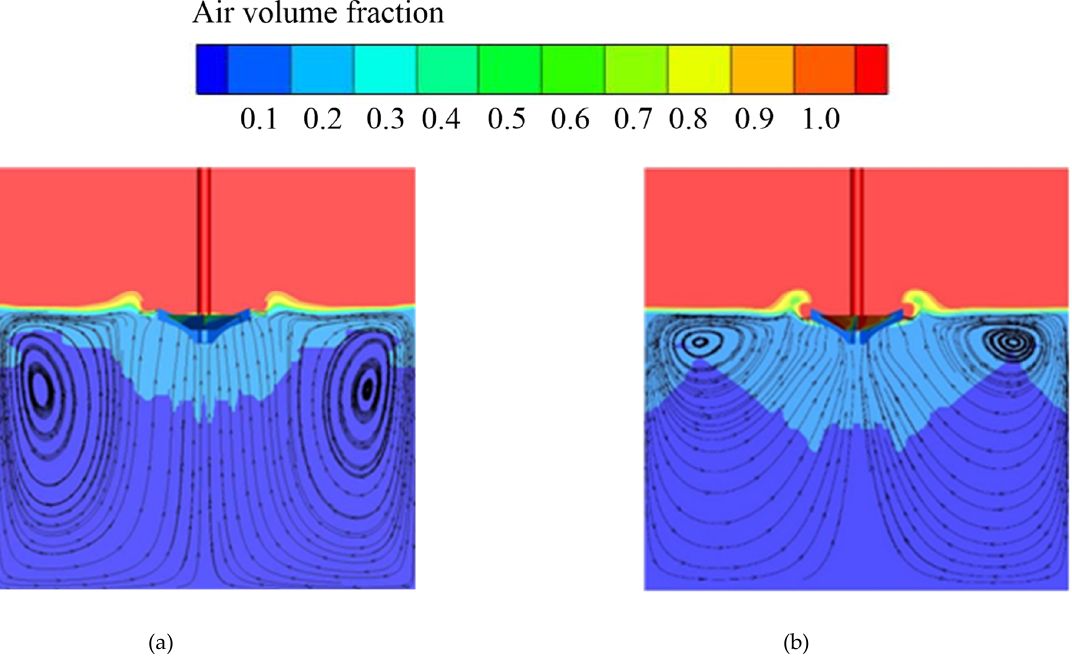
Figure 9. Gas–liquid two-phase distribution in aeration tank. ( a ) Average diameter, ( b ) PBM.